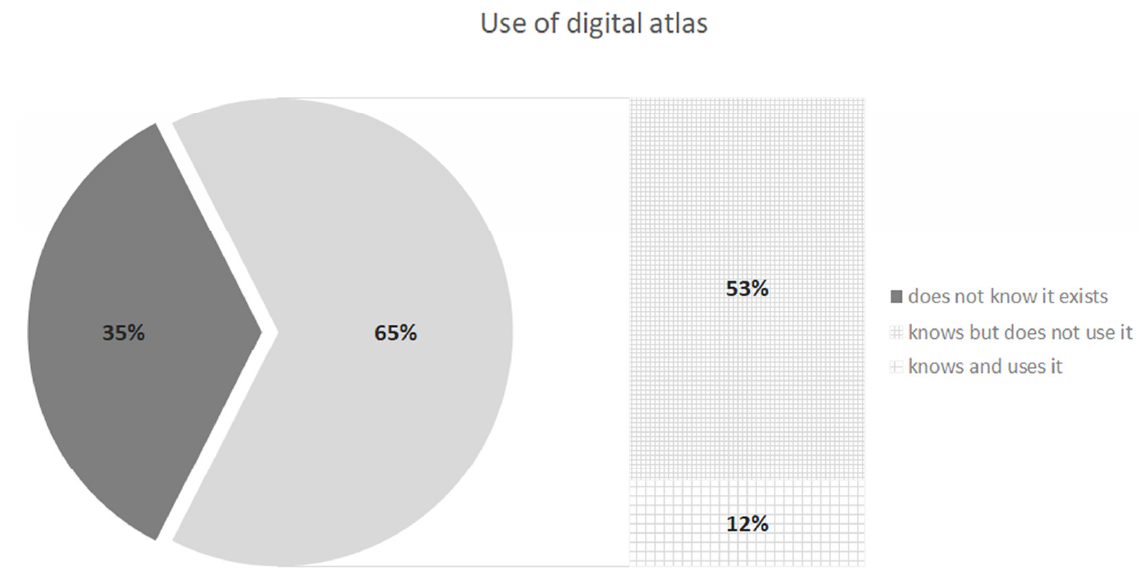
Figure 6. Summary of answers for Q14 and Q15 focusing on the awareness and use of digital versions of the atlas. Half of the geography teachers (50.9%) responded that they assigned their students homework with an atlas ( Q21 ).